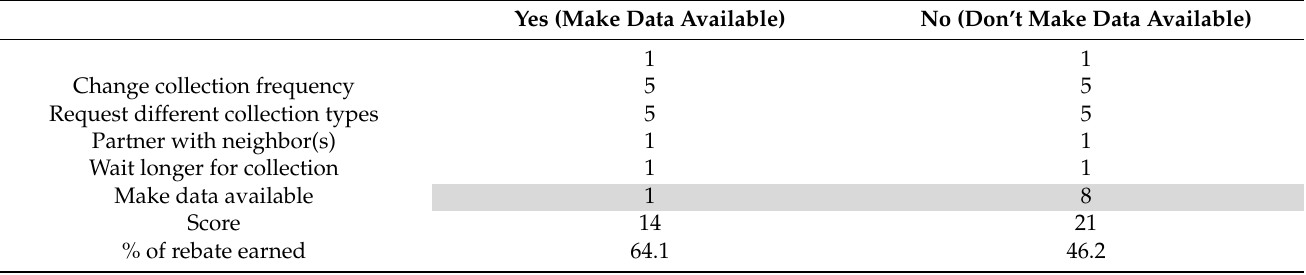
Table 7. Impact of customer making collected waste data